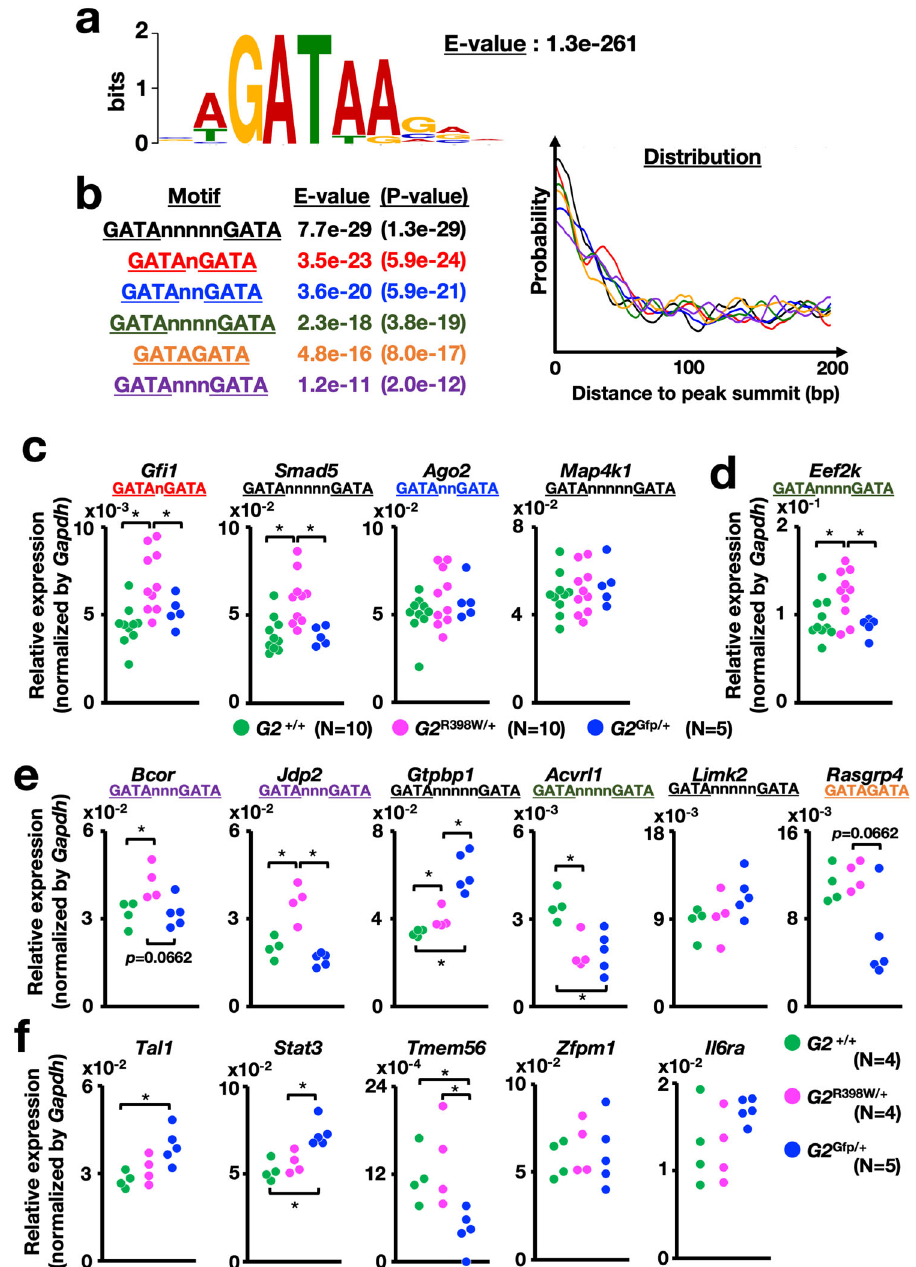
Fig. 9 Expression landscape of genes containing tandem GATA motifs in ChIP-Seq peak regions. a GATA2-binding motif in ChIP-Seq peak regions in the GATA2 ChIP-Seq dataset of murine bone marrow lineage-negative cells. b Tandem GATA motifs were used to search ChIP-Seq peak regions containing tandem GATA motifs. Motifs are arranged in ascending order according to the E-value. The right panel shows the distance distributions between ChIP-Seq peak summits and the center of the motifs with color-matched lines. c – e Dot plots for the expression of genes containing the tandem GATA motif(s) in bone marrow LSK cells of 5- to 6-month-old mice. Genes commonly found in two datasets ( c ), found in the ENCODE dataset ( d ), and found in the ChIP- Atlas dataset ( e ) are shown. Tandem GATA motif types found in the ChIP-seq peaks in individual genes are shown. f Dot plots for the expression of genes harboring only a single GATA motif(s) in their proximity in bone marrow LSK cells of 5- to 6-month-old mice. * p < 0.05. Numbers of mice are indicated in the fi